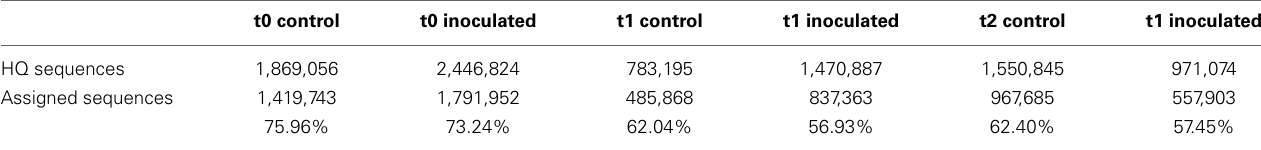
Table 6 | Sequences assigned to all functional subclasses within the metagenome data sets calculated within the MG RAST analysis software with default settings.